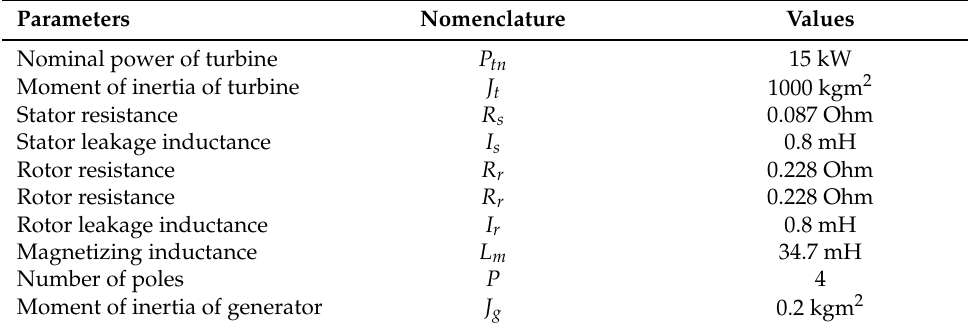
Figure 5. Variable speed wind turbine based on SCIG [14]. Table 1. Wind turbine parameters.